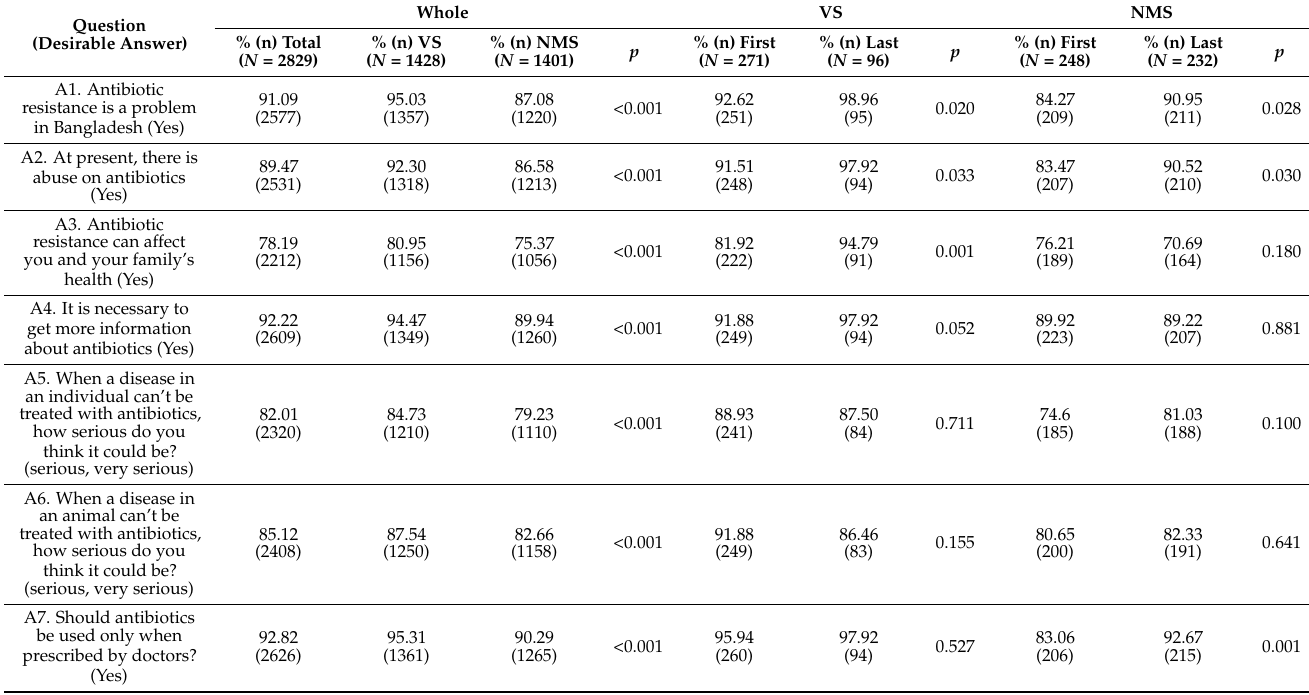
Table 5. Proportion of responses to questions about